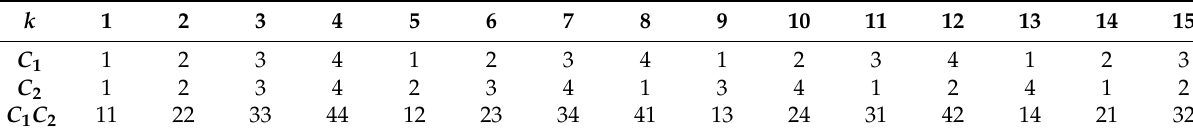
Figure 1. The designed codewords of the proposed method.